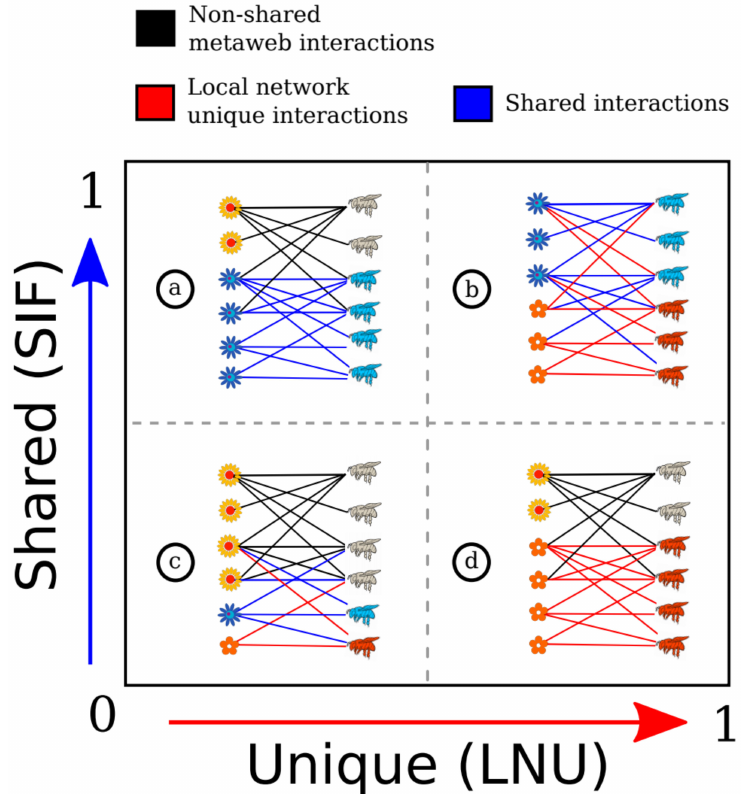
Figure 5. Potential use of the Local Network Uniqueness (LNU) and Shared Interactions Frequency (SIF) indexes. Measuring the values of LNU and SIF of a set of networks, we can plot their values as the interaction uniqueness in the x-axis and commonness in the y-axis. By dividing the plot into four quadrants we can also interpret the values of LNU and SIF, in which we can have four possible scenarios denoted by the letters in the quadrants, where ( a ) networks with high number of shared interactions and low number of unique interactions in relation to their metaweb, ( b ) networks with high number of shared interactions and high number of unique interactions in relation to their metaweb, ( c ) networks with low number of shared interactions and low number of unique interactions in relation to their metaweb and, ( d ) networks with low number of shared interactions and high number of unique interactions in relation to their